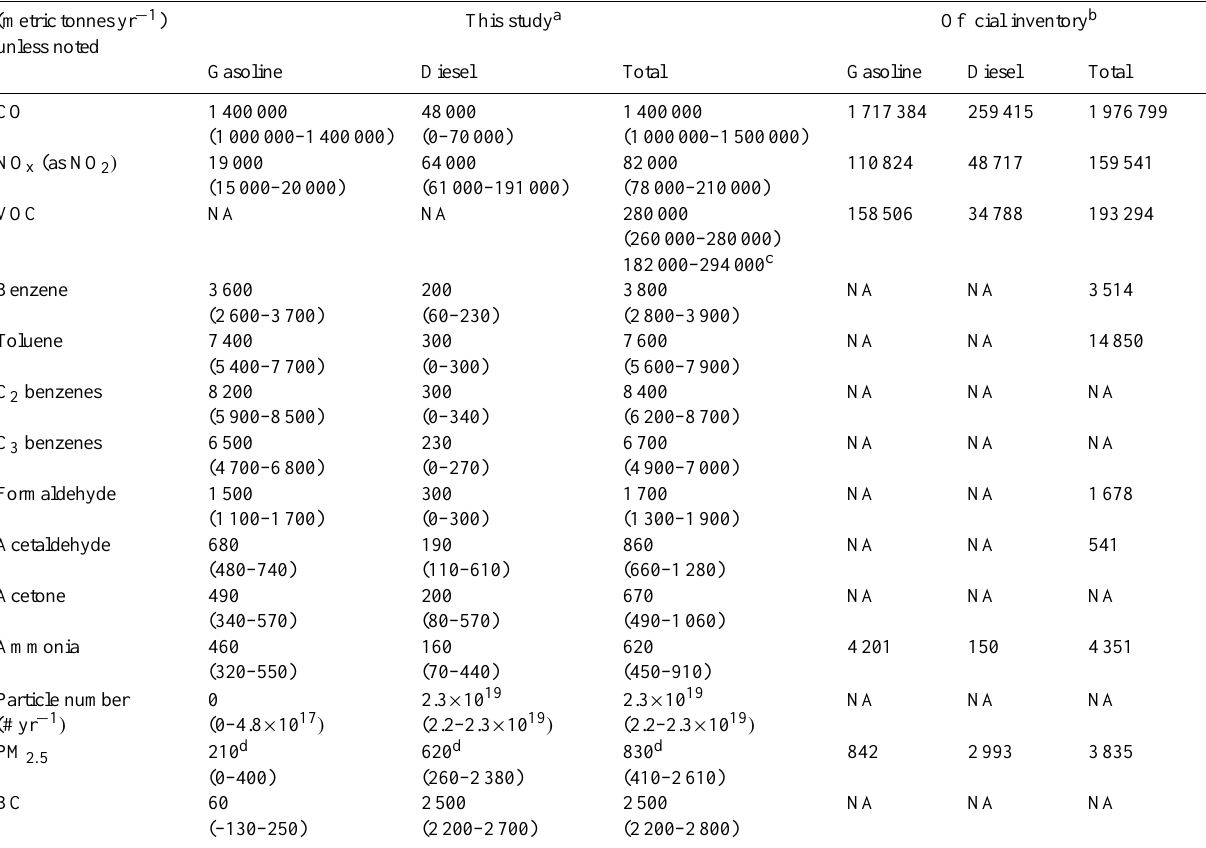
Table 4. Total emissions in 2006 from on-road motor vehicles in Mexico